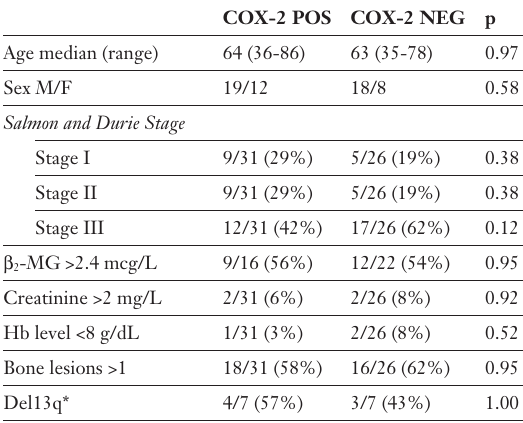
Clinical characte- ristics of patients at diagnosis.